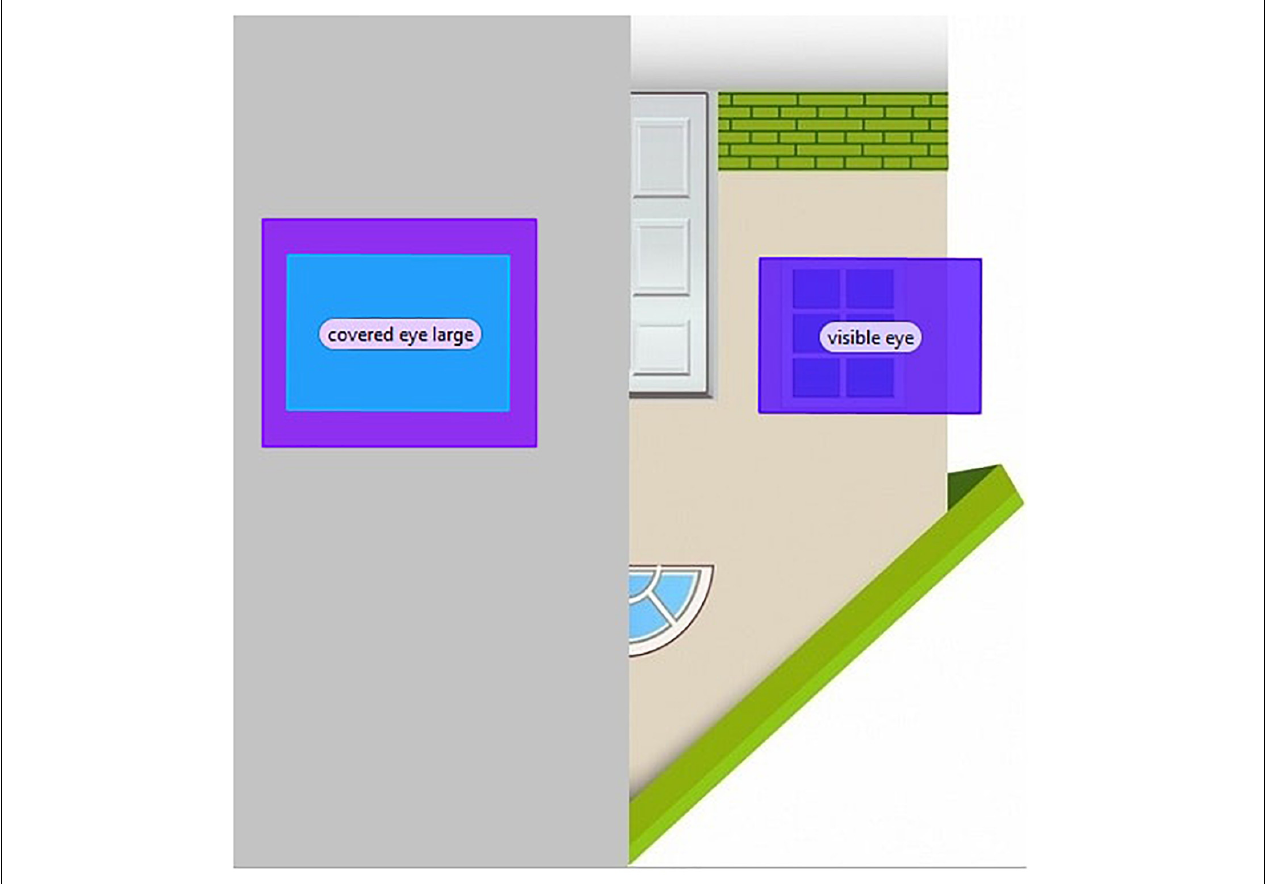
FIGURE 9 | Areas of interest for a house